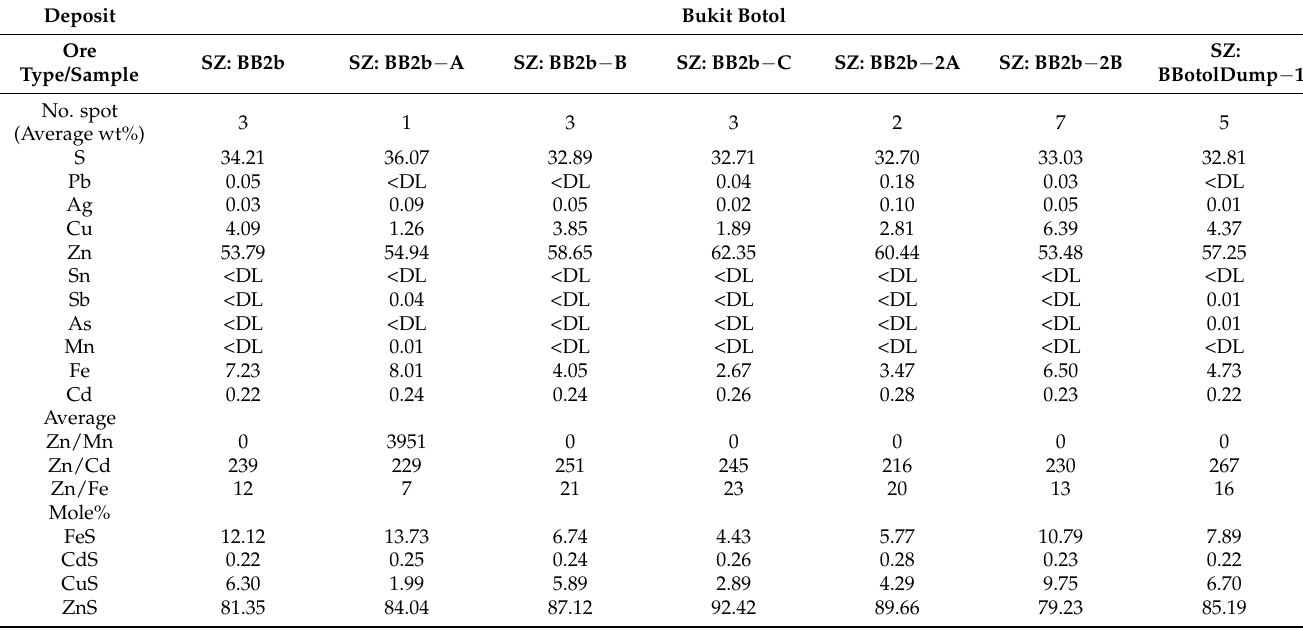
Table 2. Average chemical compositions of the representative sphalerite in a stringer zone from the Bukit Botol deposit, Central Peninsular Malaysia.